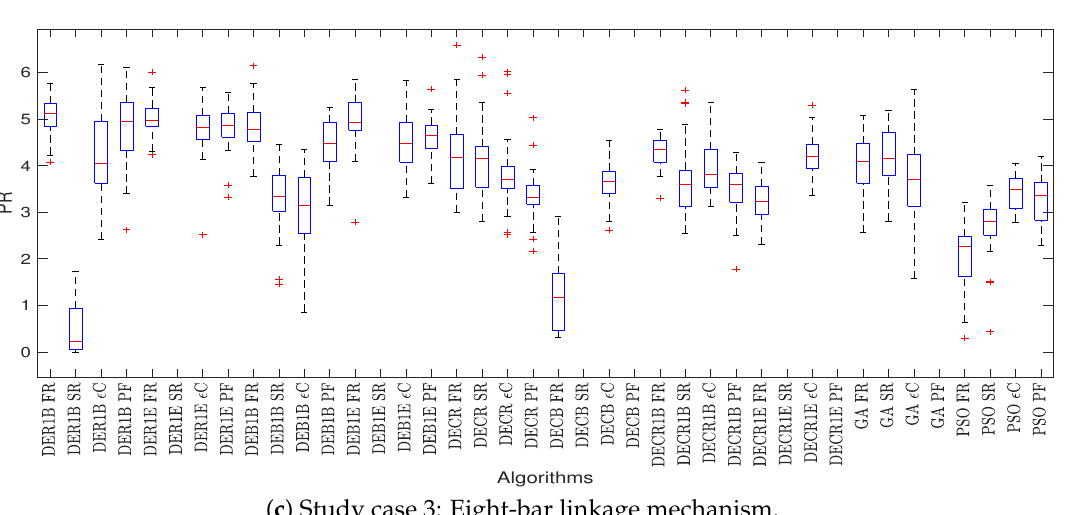
Figure 7. Box plot of the sample distribution obtained by PR in ten metaheuristics at each study case of mechanism synthesis for lower limb